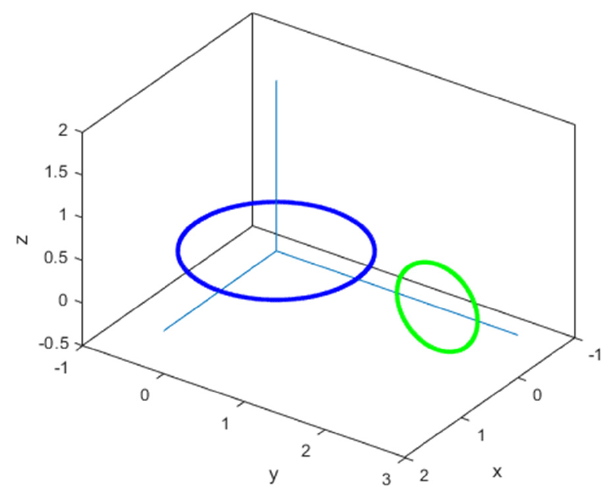
Figure 9. Case (a): two perpendicular circular loops. Not a singular case, ( a = 1, b = c = 0, L = l = 1).